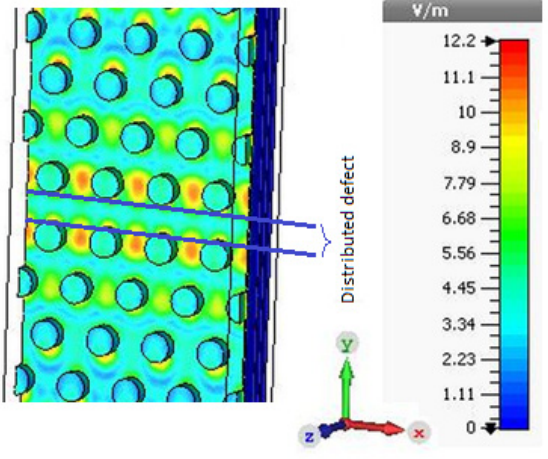
Figure 6. Close-up of the electric field amplitude at the frequency 545 THz on the surface of PPhC with the optimized gap defect. The structure is excited by a normally incident plane wave of amplitude 1 V/m.